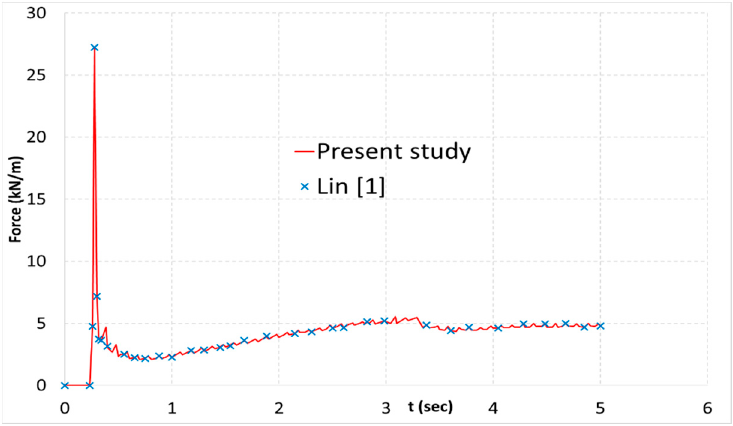
Figure 6. A comparison of the time history of the fluid forces on the cylinder between the present study (solid line) and the Lin [1] study (x).